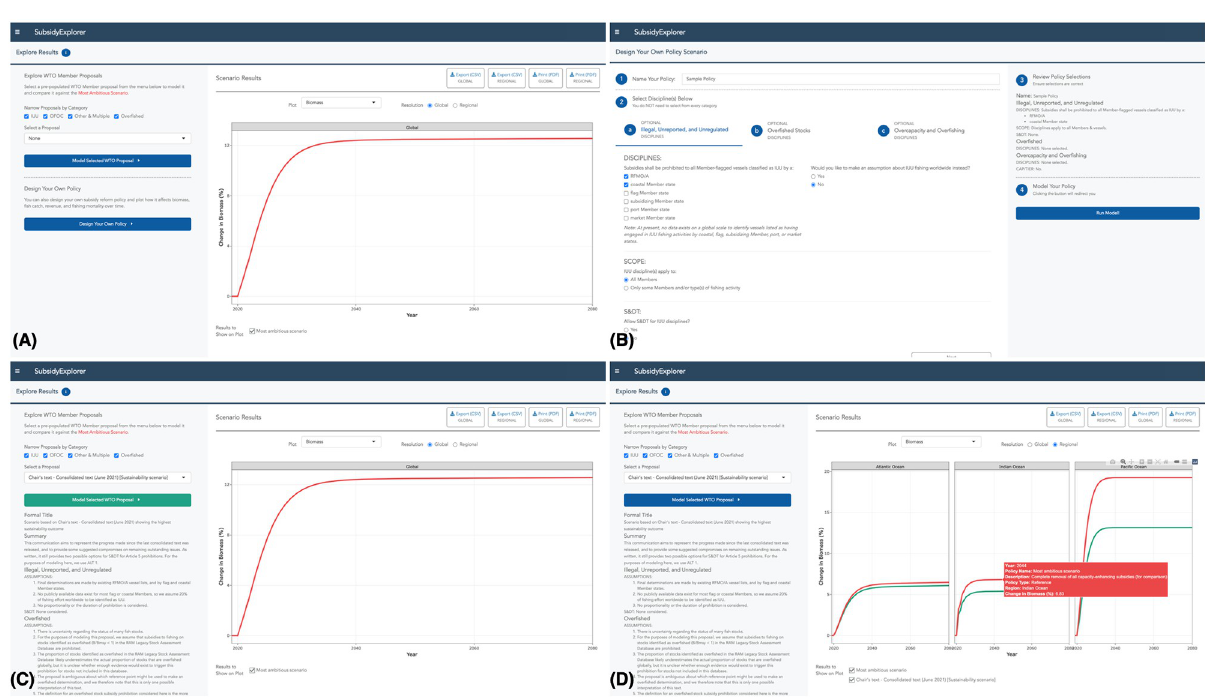
Fig 3. Learn How Subsidy Reform Can Help Fish: Policy comparison portal. The first section of SubsidyExplorer executes the tool’s primary feature: a decision-making framework for comparing different subsidy reform proposals. Within this section, the user can (A) select from proposals that have been submitted to the WTO, (B) design their own policy, (C) run a global bioeconomic projection model, and (D) evaluate the global and regional effects of the selected policy on different biological and economic indicators. Republished from www.subsidyexplorer.com under a CC BY license with permission from UCSB, original copyright